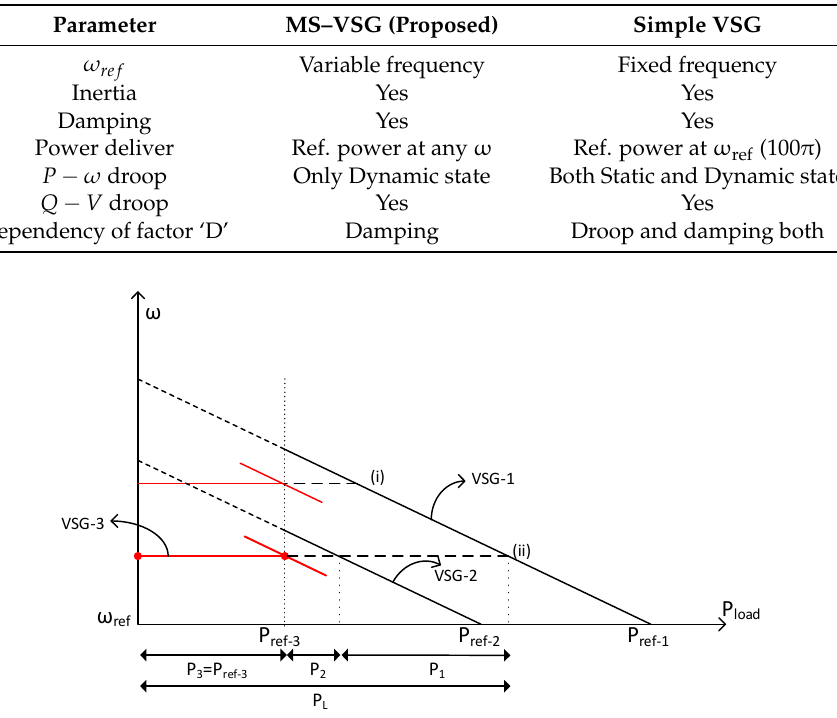
Table 3. Comparison of MS-VSG and Simple VSG control.